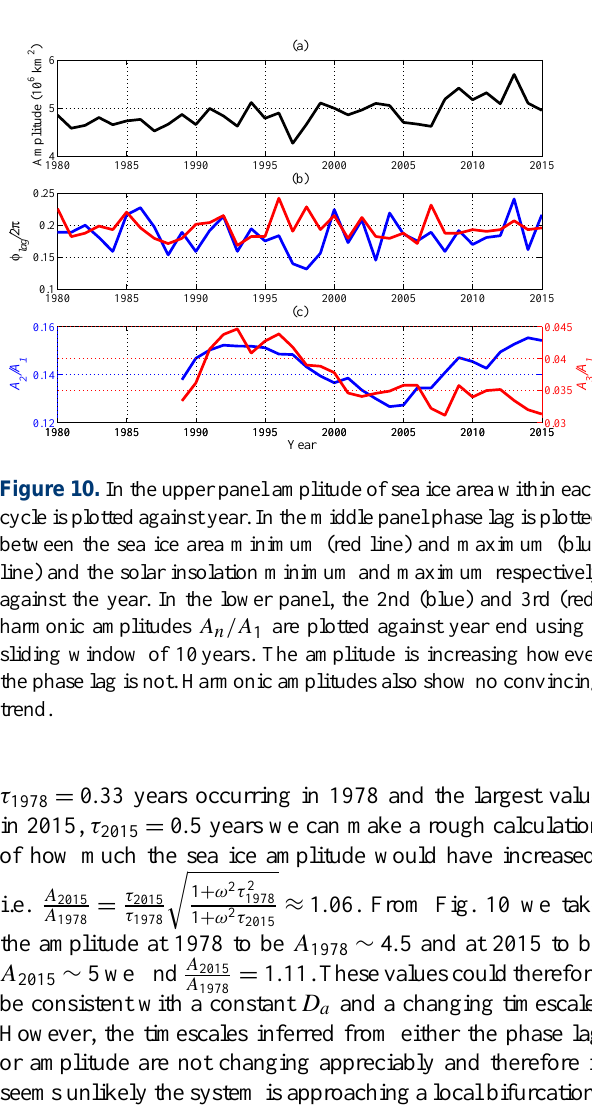
Fig. 12. Lag 1 autocorrelation is plotted against sliding win- dow end year ( x axis) and day of the year in each cycle the return map generated on (the y axis). We create new return